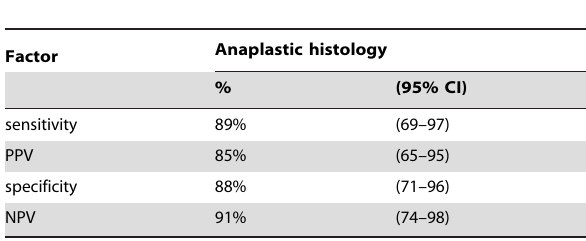
Table 3. Predictive relationship of visible PpIX fluorescence and anaplastic histology.